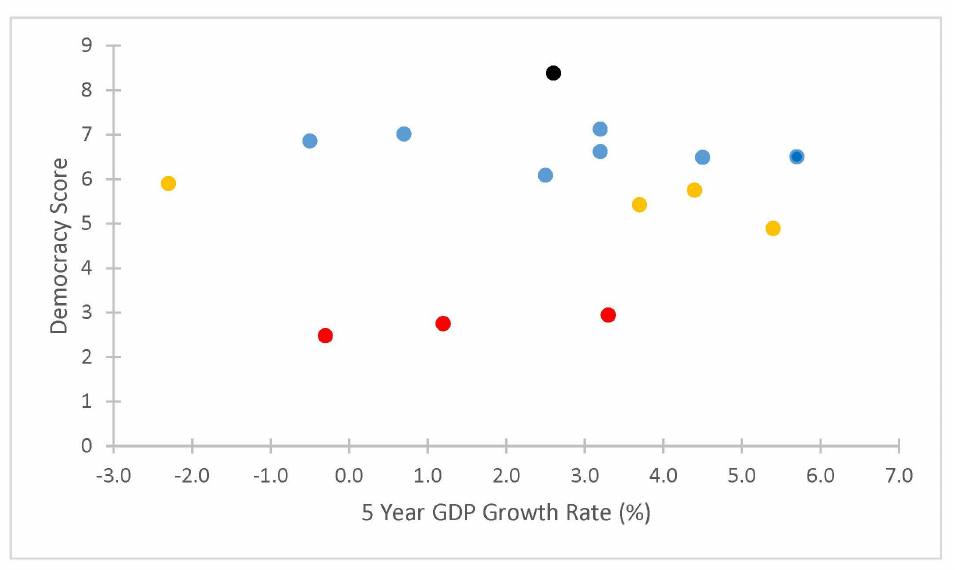
Figure 3. Democracy and Economic Growth. Note: Democracy scores were obtained from The Economist, while GDP growth rates derive from the Heritage Foundation data. Red indicates authoritarian regimes, yellow hybrid regimes and blue a flawed